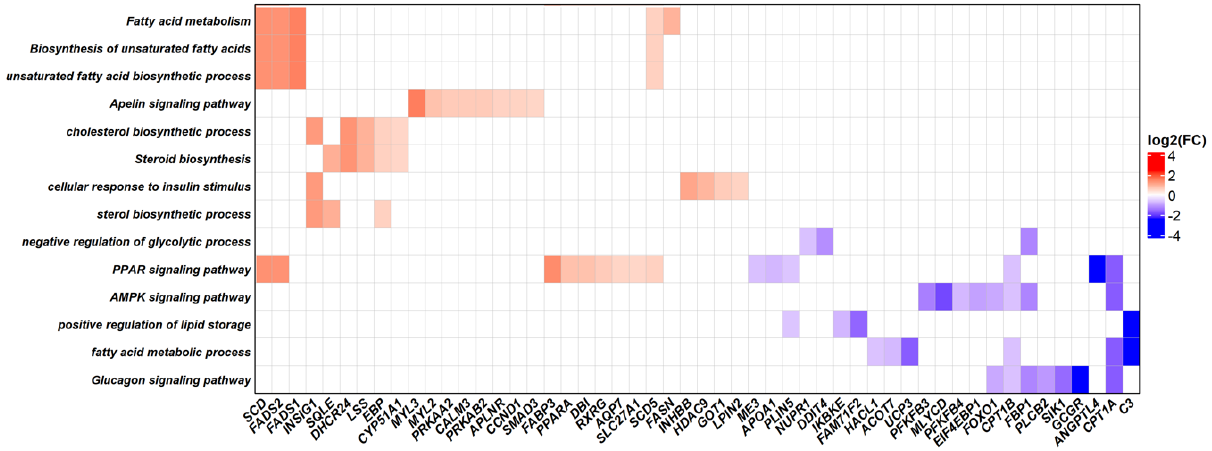
Figure 4. Relationship between up- and down-regulated DEGs identified in G2 at weaning (x-axis) and enriched biological processes and pathways, which are highlighted due to their relationships with each other and possible relationships with intramuscular fat content in cattle (y-axis). The color scale indicating the log 2 fold change is given on the right side of the figure.